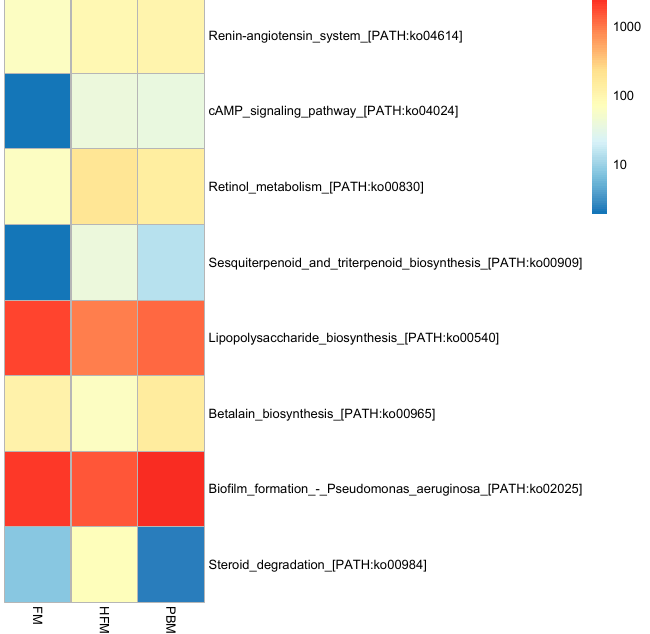
Figure 8. Significantly different ( p < 0.05) predicted functional pathways of the bacterial relative abundances between fish fed the FM, PBM50 and HFM50 diets.